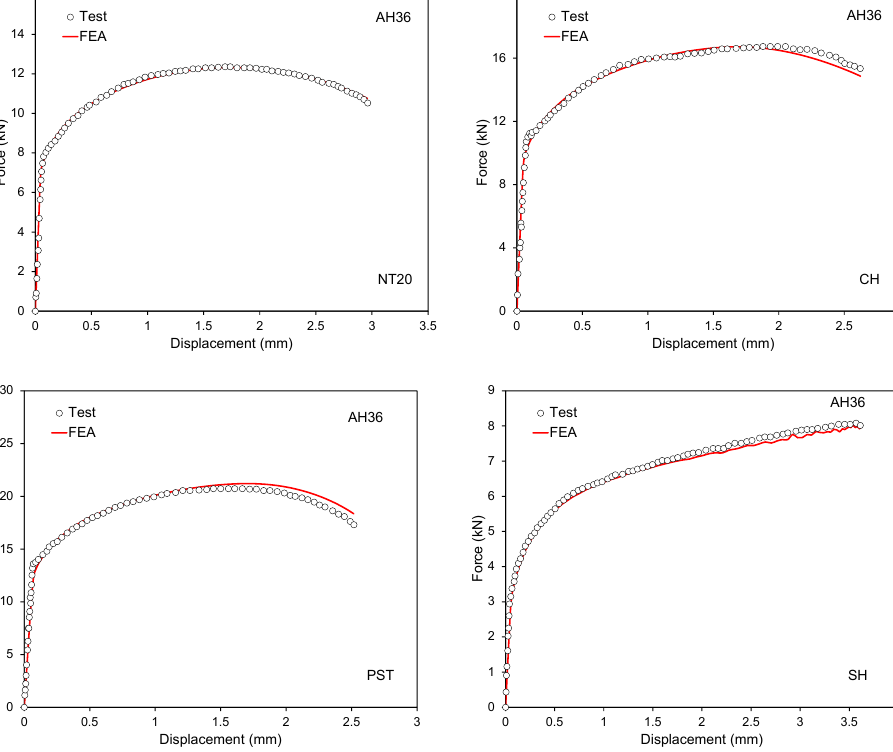
Figure 13. Comparison of numerically predicted and experimentally obtained force displacement curves for the AH36 grade steel